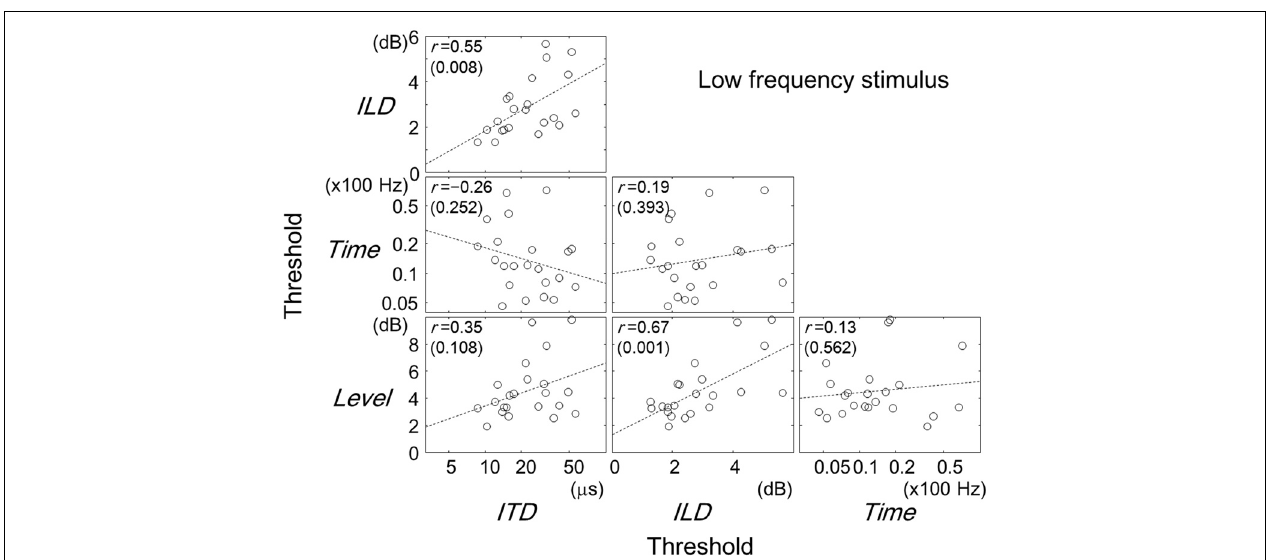
FIGURE 1 | Means and standard errors of individual listeners’ thresholds, expressed by the crosses and error bars, respectively. Each panel represents one task, and each set of cross and error bar represents one listener. Within each panel, listeners are sorted according to the mean